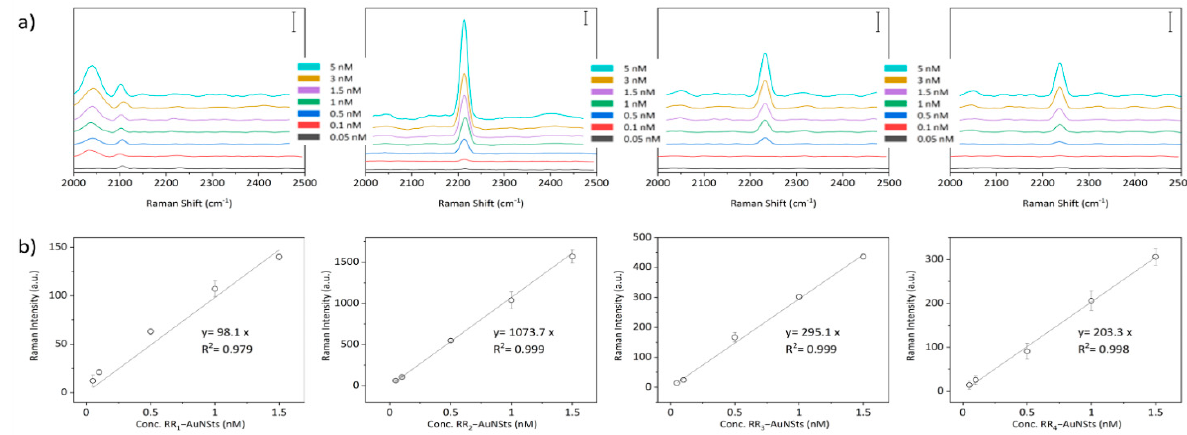
Figure 6. ( a ) Raman ‐ SERS spectra acquired against RR@AuNSts colloidal solutions at decreasing concentrations, ranging from 5 nM to 0.05 nM. Scale bar is 500 counts in all cases. ( b ) Linear concentration dependence of Raman intensity of the characteristic vibrational peak of the different RR@AuNSts nanoprobes ( n = 3; error bars represent standard deviation. Solid line shows a linear fitting).